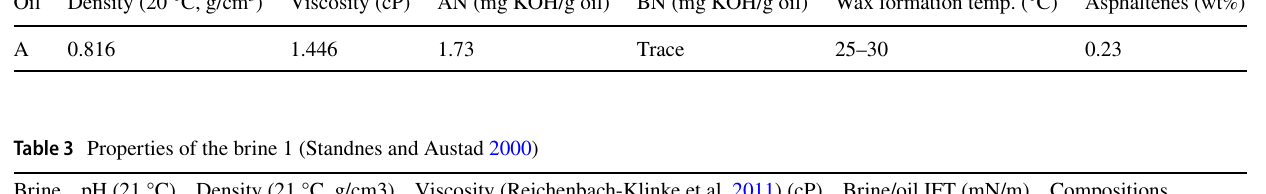
a Density, the value refers to the paper of Hjuler and Fabricius